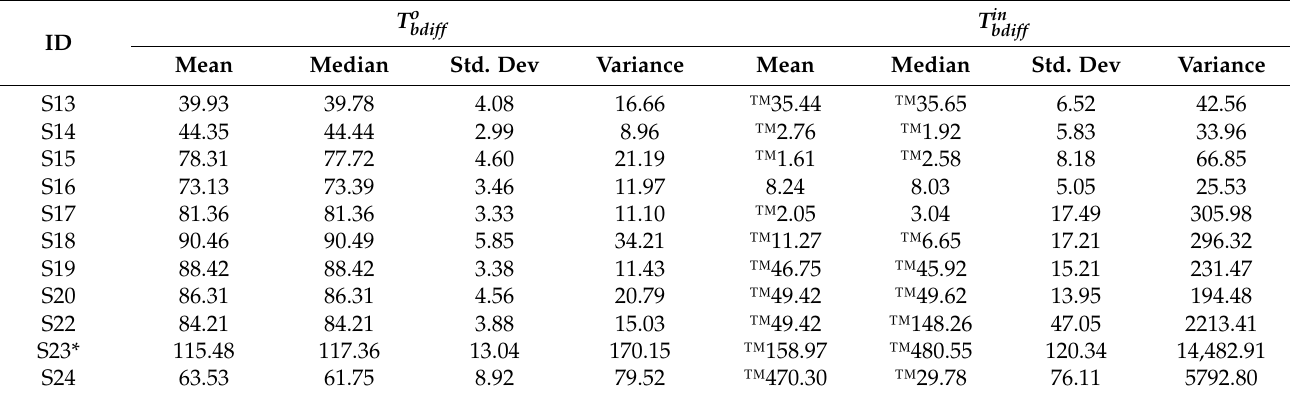
Table 5. Temperature statistics in inner T in T o bdiff